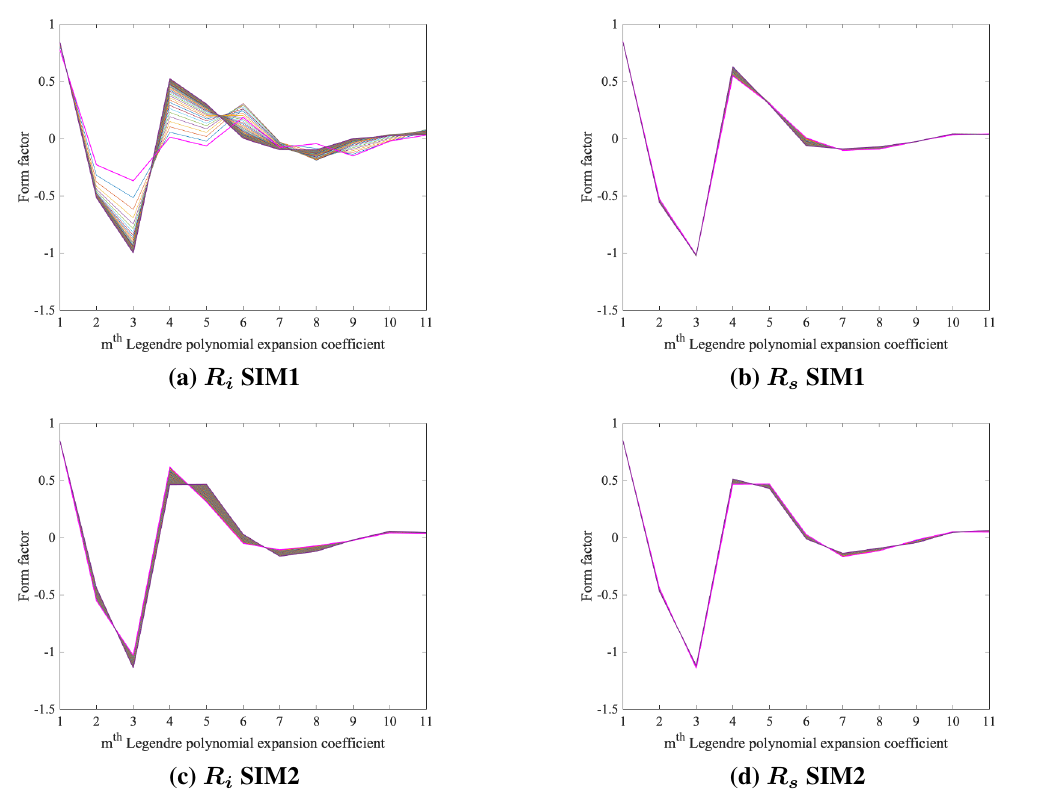
Figure 3: Legendre polynomial expansion of coupling coefficients.